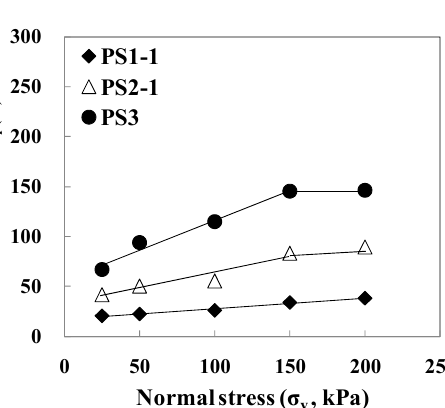
Figure 5. Relationship between normal stress and pullout strength.